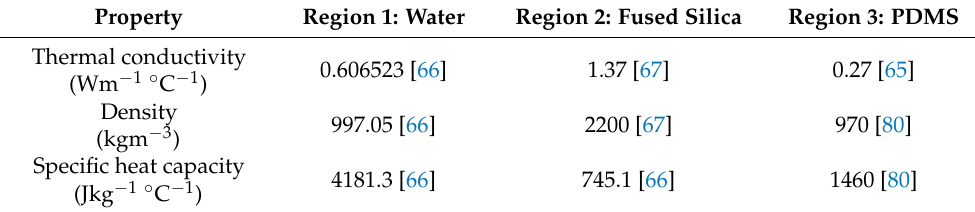
Table 1. Thermal property values used in the finite element (FE)